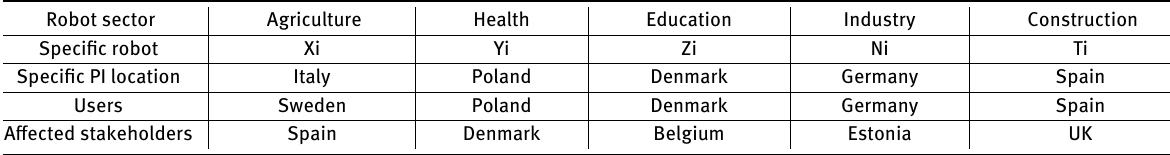
Table 1: Example of REELER case